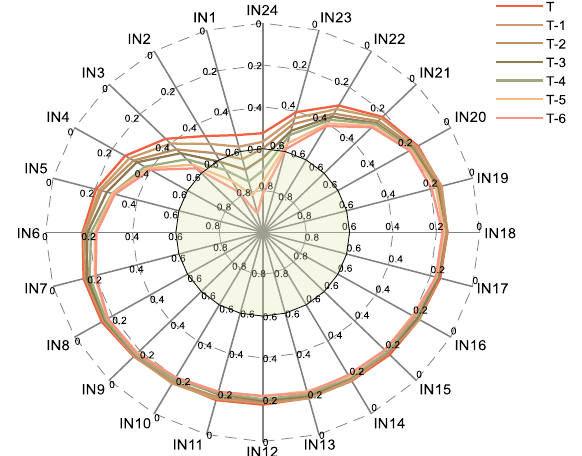
Figure 7. MIC of historical load for dataset 2.